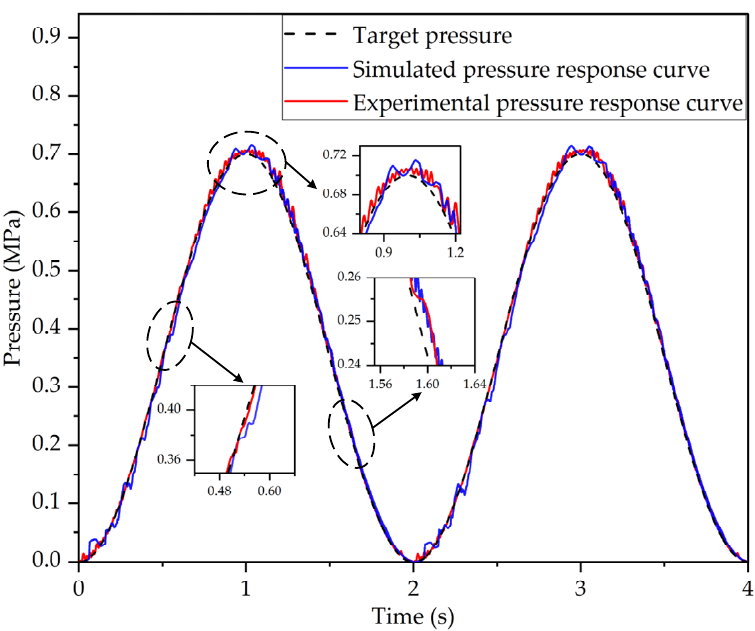
Figure 11. The outlet pressure response characteristics curves of the LF-APRV under sinusoidal target pressure obtained by test and simulation.